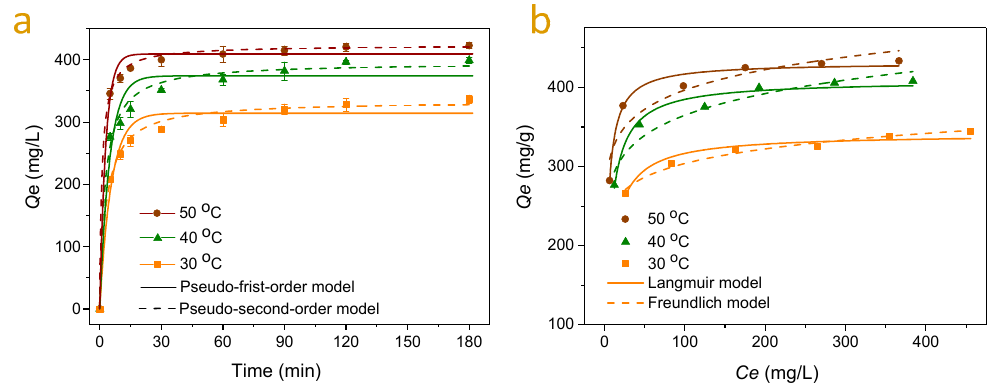
Table 2. Kinetic and isotherm parameters for adsorption of methylene blue on 80% ethanol insoluble subdivision (S3).